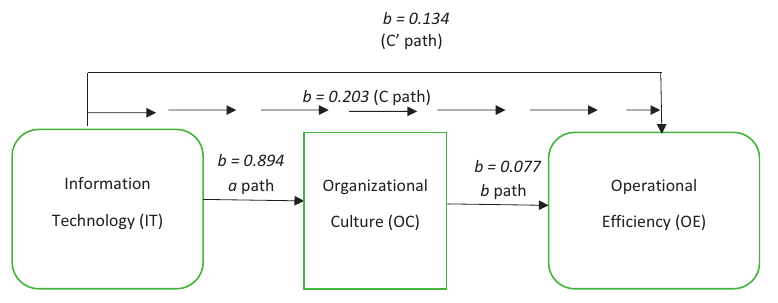
Figure 4. Model path